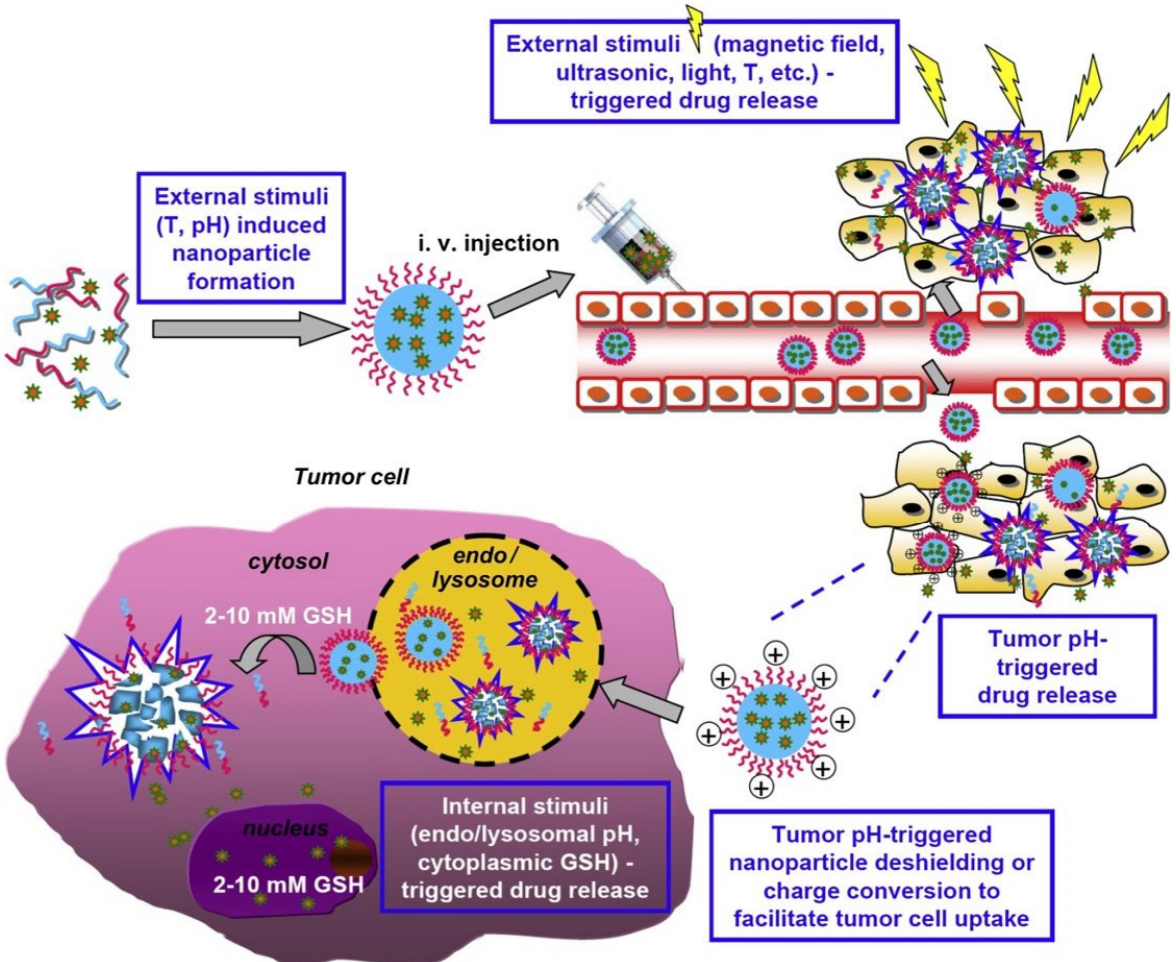
Figure 10. Scheme of internal and external multi-stimuli action in the case of a polymeric nanoparticle material. Reproduced from [127], with permission from © 2013 Elsevier. Table 4. Examples of dual and multi-responsive nanomaterials and their biomedical applications. Nr.